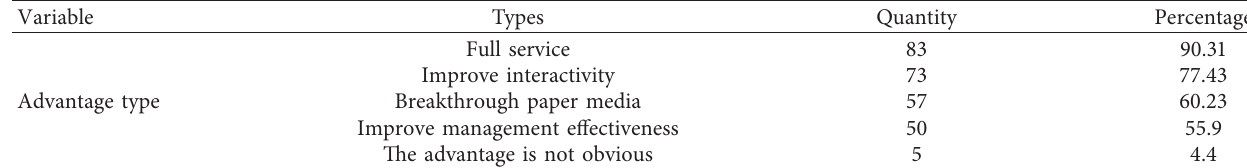
Table 3: User advantage